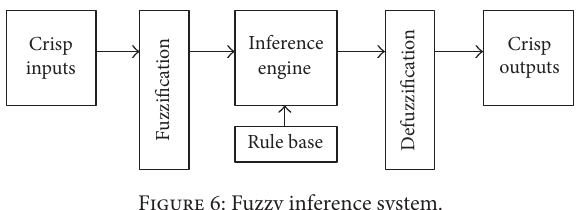
Figure 6: Fuzzy inference